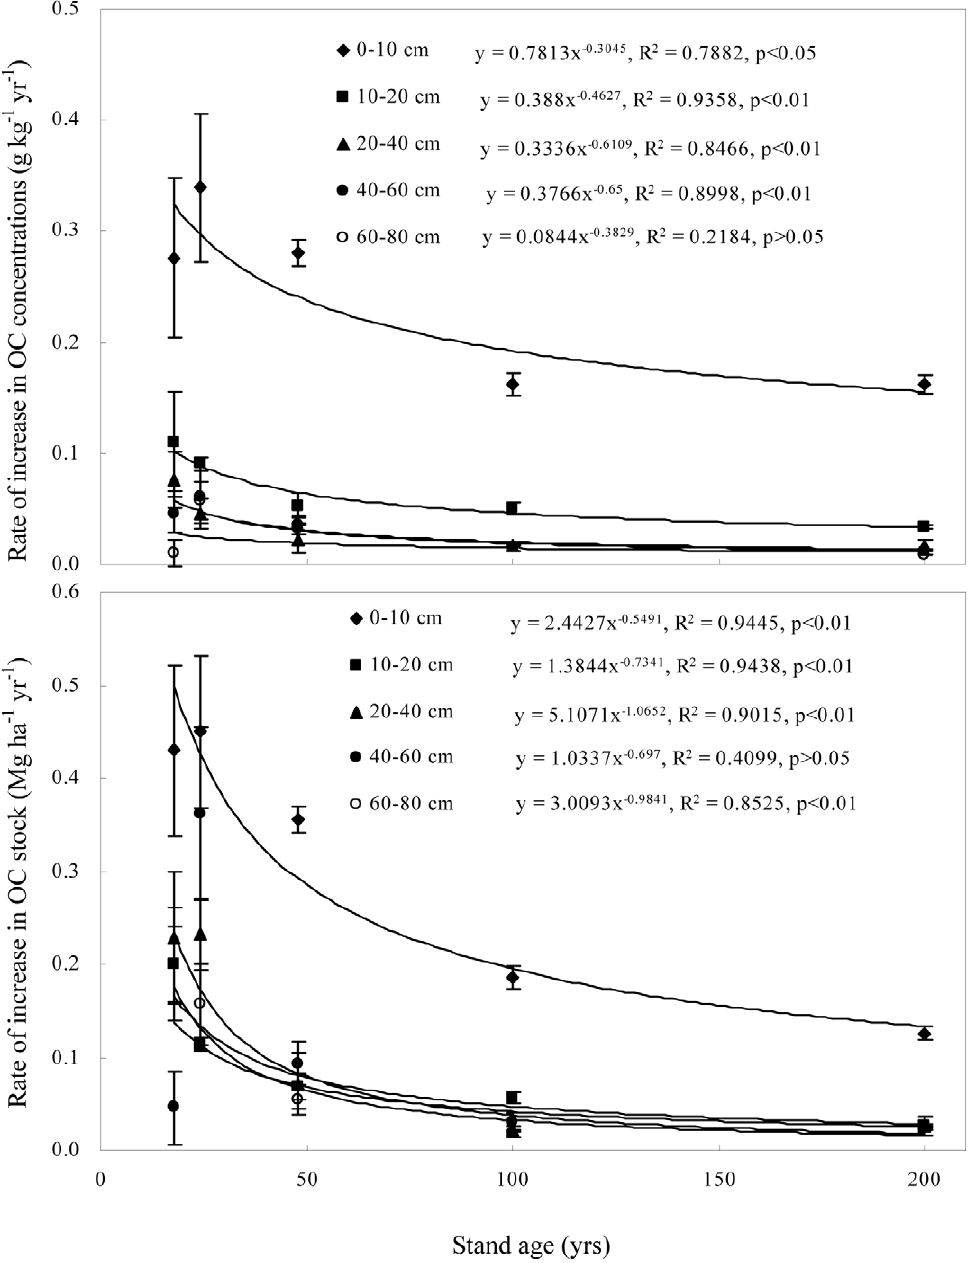
Figure 3. Relationships between stand age and the rate of increase in total OC concentrations and stocks in mineral soils (the error bars are standard deviation of the means).